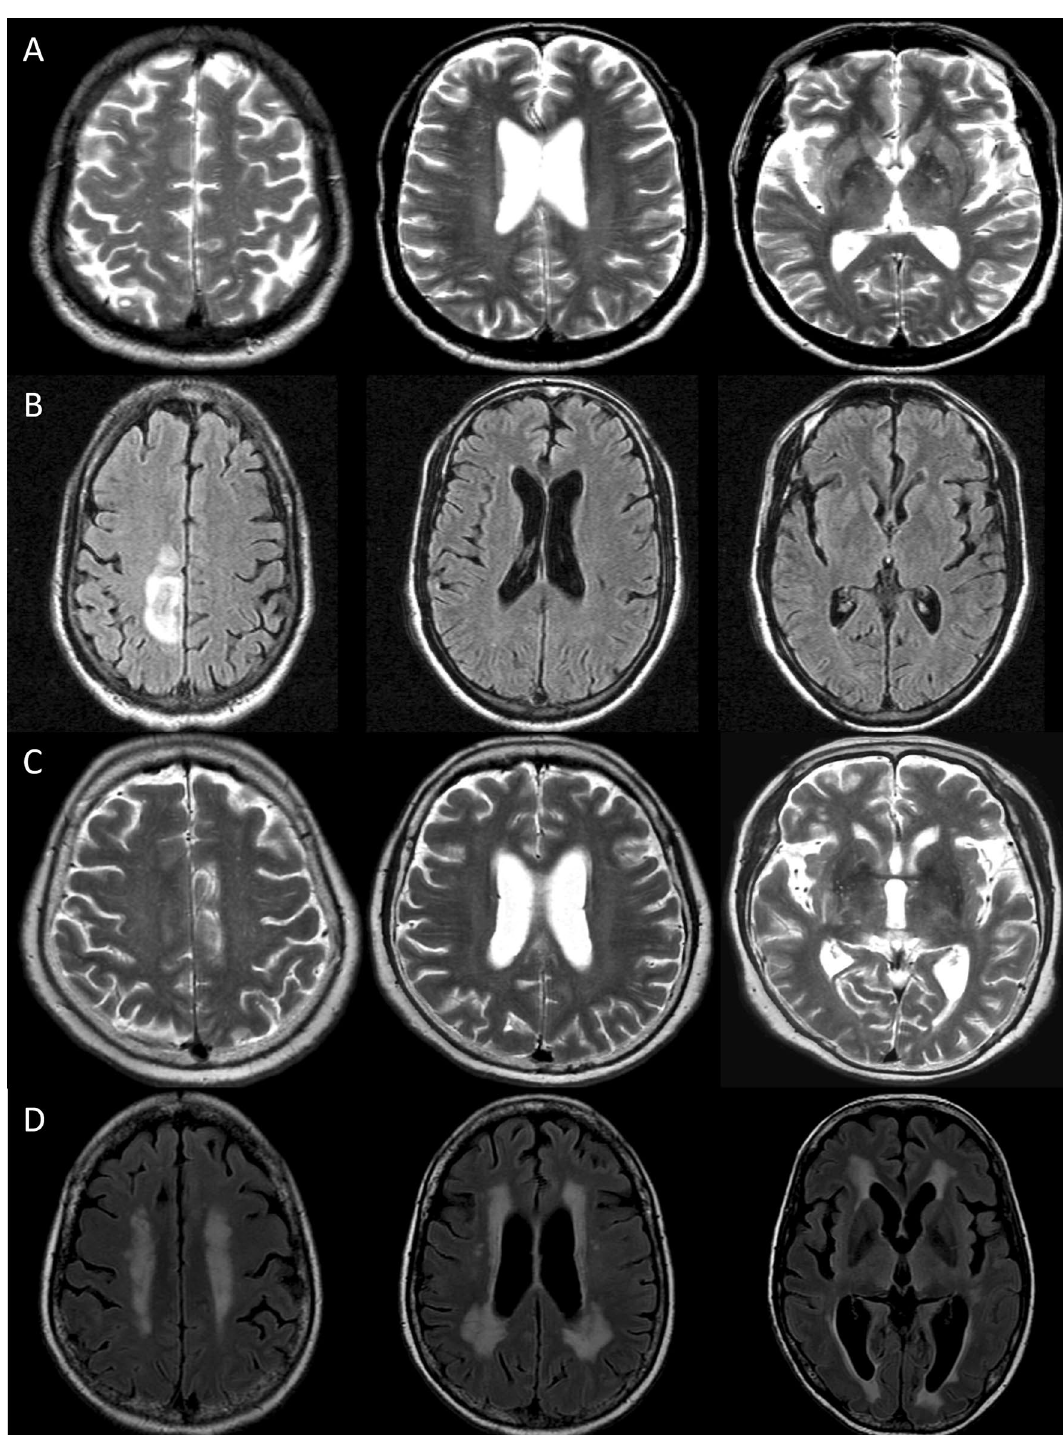
Figure 4. Illustrative cases. A 56-year-old man with underlying human immunodeficiency virus infection presented with fever and headache (initial modified Rankin Scale [mRS] score = 1). Baseline MRI showed enlarged periventricular space (EPVS) in centrum semiovale (CS-EPVS score = 4) and in basal ganglia (BG-EPVS score = 2, Panel ( A )). The patient was treated with intravenous amphotericin combined with fluconazole for two weeks. However, follow-up MRI at 2 week showed interval development of parenchymal T2 high-signal intensity (HSI) at the right frontal cortex on T2 fluid attenuated inversion recovery (FLAIR) images (Panels ( B )). Despite the amphotericin-based combination treatment for 40 days and oral fluconazole for 176 days, the mRS score at 6 month was 4. A 72-year-old immunocompetent woman presented with fever and headache (initial mRS score = 1). At baseline MRI, CS-EPVS score was 3 and BG-EPVS score was 2 (Panels ( C )). The patient was treated with intravenous amphotericin combined with flucytosine and maintained with oral fluconazole for 214 days. However, gait disturbance and cognitive impairment progressed (6-month mRS score = 4). Follow-up MRI at 6 month showed interval development of periventricular extension of the T2 HSI and slight hydrocephalus on T2 FLAIR images (Evans ratio = 0.35, Panels ( D